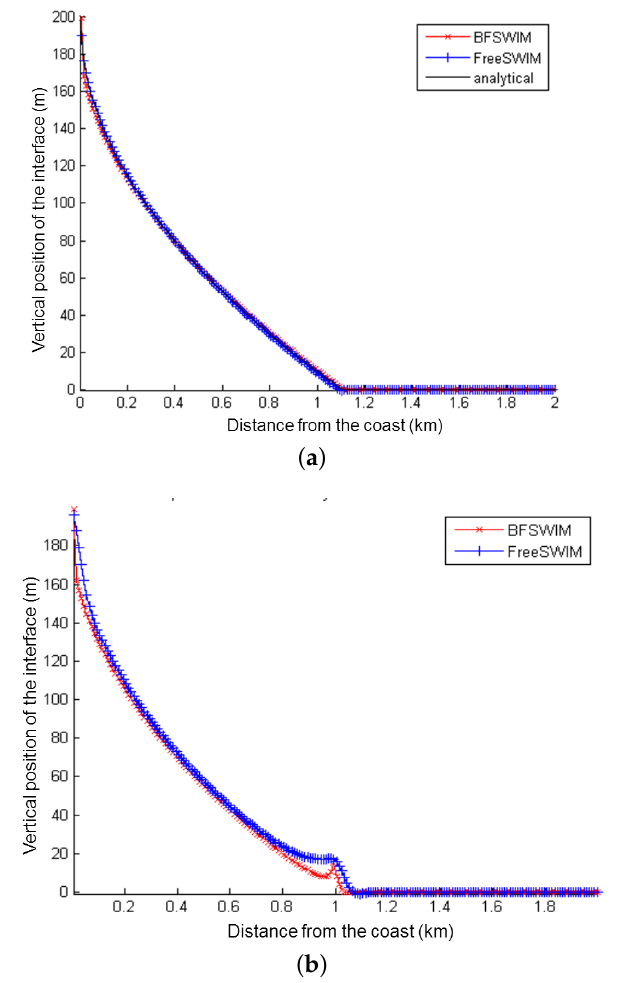
Figure 6. Comparison of solutions ( a ) without pumping and ( b ) with pumping. FreeSWIM vs. BFSWIM and analytic solution in ( a ) and FreeSWIM vs. BFSWIM solution in ( b